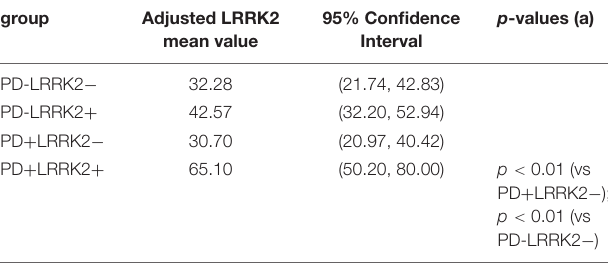
TABLE 4 | ANCOVA Statistical analysis of CSF LRRK2 levels following age and gender adjustment.